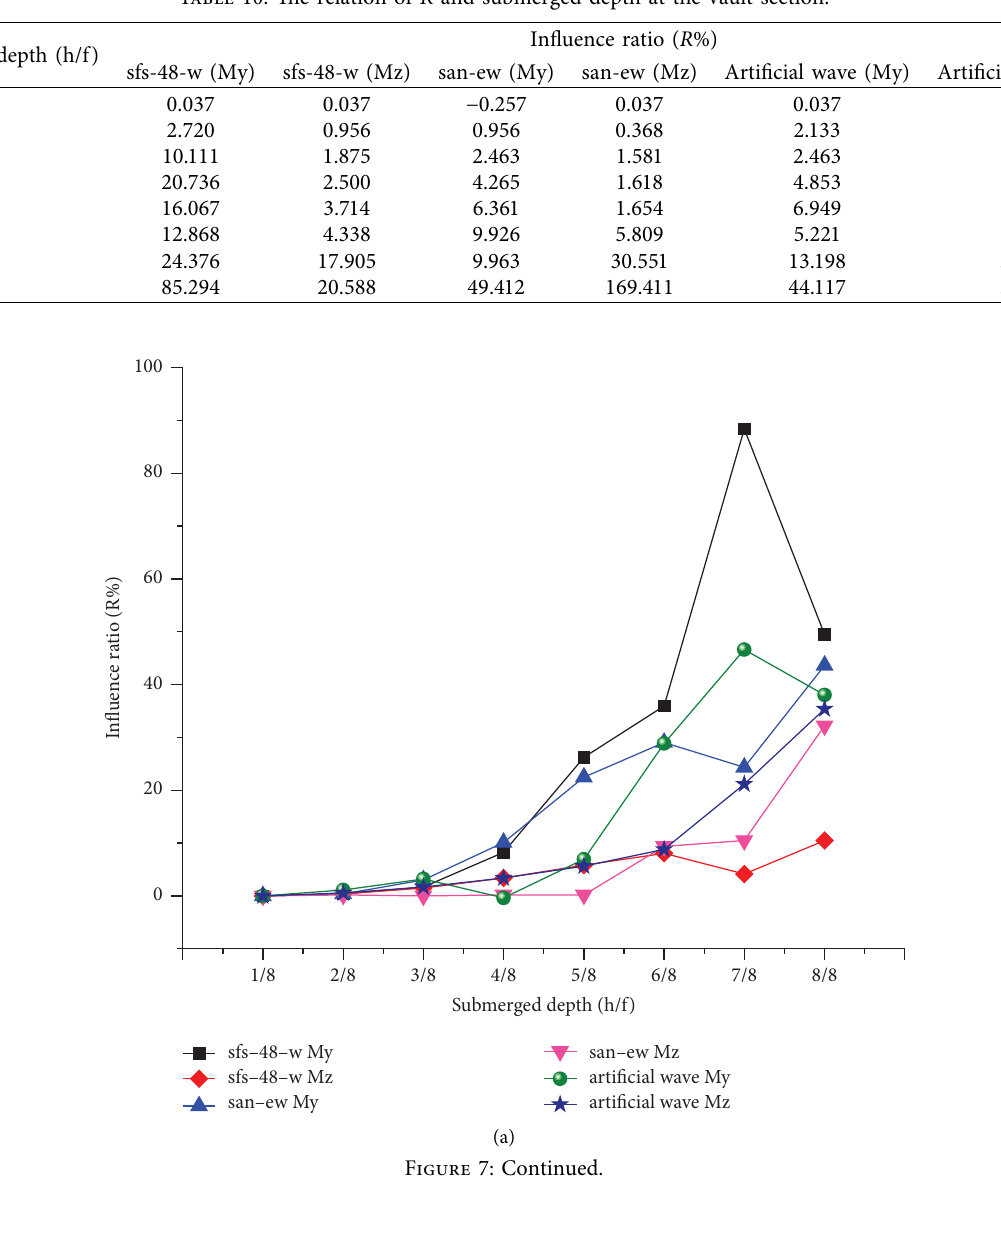
Table 10: Te relation of R and submerged depth at the vault section.